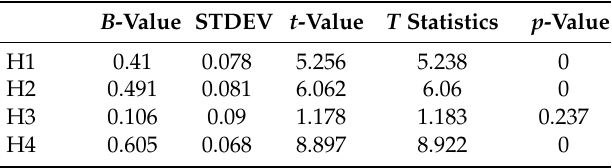
Table 6. Results of the model